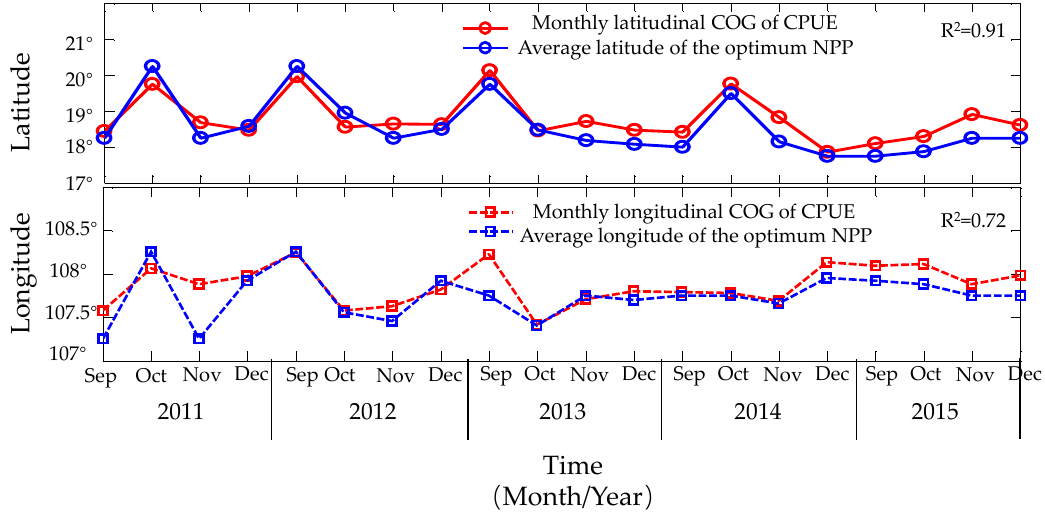
Sep Oct Nov Dec Sep Oct Nov Dec Sep Oct Nov Dec Sep Oct Nov Dec Sep Oct Nov Dec